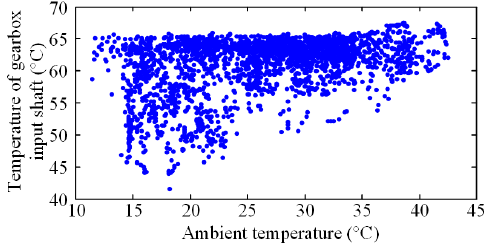
Figure 3. Relationship between the gearbox input shaft temperature of a VSCF WT and the ambient temperature.